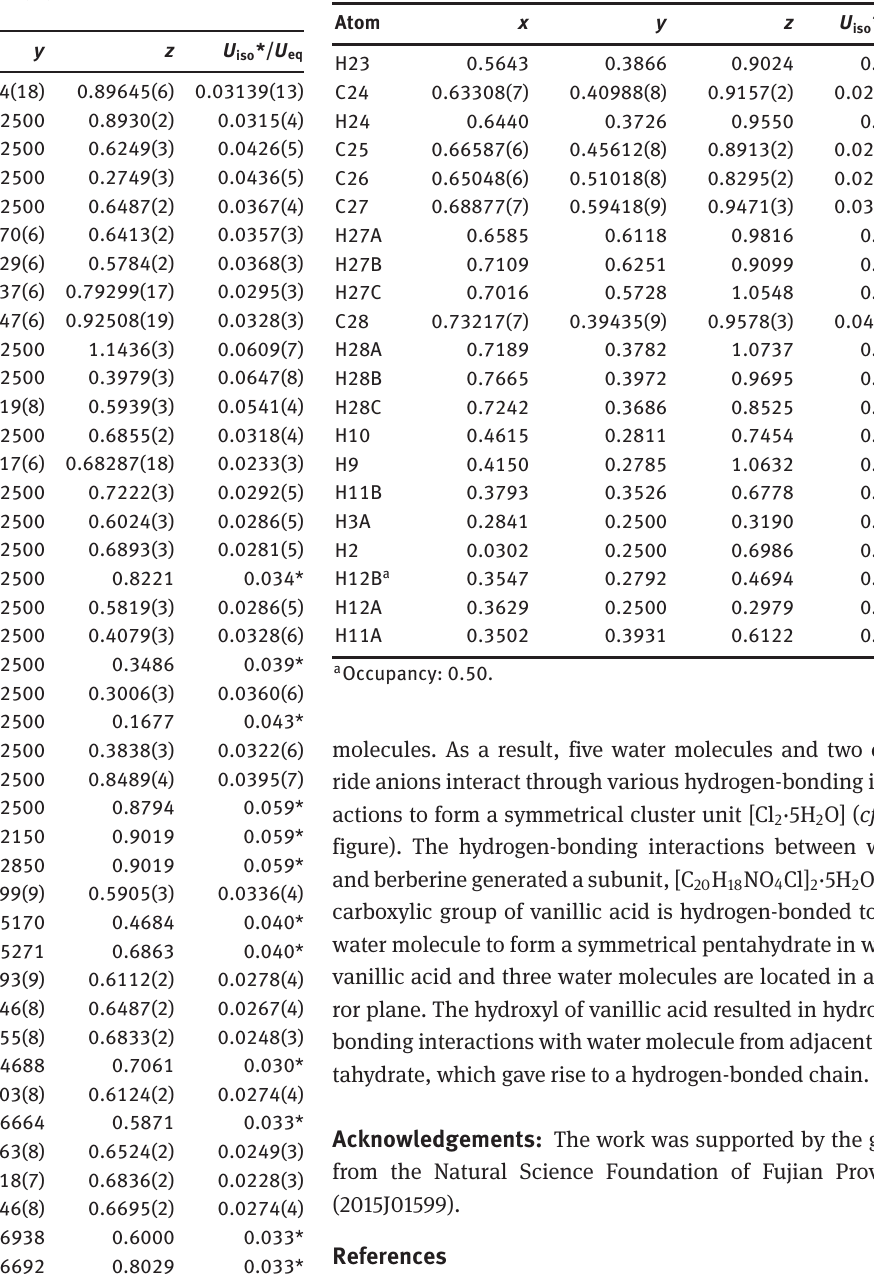
Table 2: Fractional atomic coordinates and isotropic or equivalent isotropic displacement parameters (Å 2